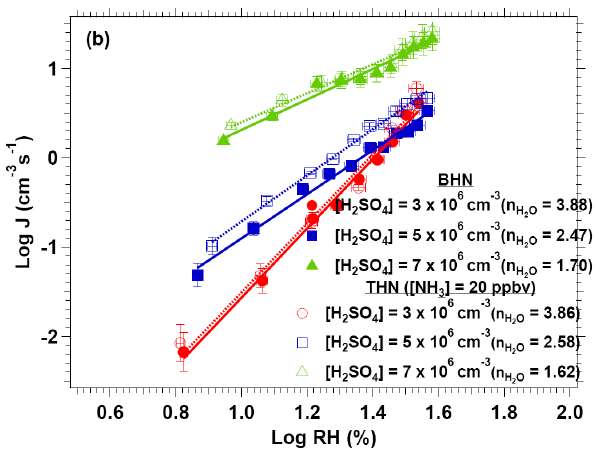
Fig. 3b. Log J vs. Log RH. [NH 3 ]=20 ppbv. The total flow Figure 3b. Log J vs. Log RH. [NH 3 ] = 20 ppbv. The total flow through the reactor is 13.1 lpm 641 through the reactor is 13.1lpm (5.6lpm through the nucleation re- gion and 7.5lpm to the two CIMSs), corresponding to a residence (5.6 lpm through the nucleation region and 7.5 lpm to the two CIMSs), corresponding to a 642 time through the nucleation region of 120s. residence time through the nucleation region of 120 s. 643